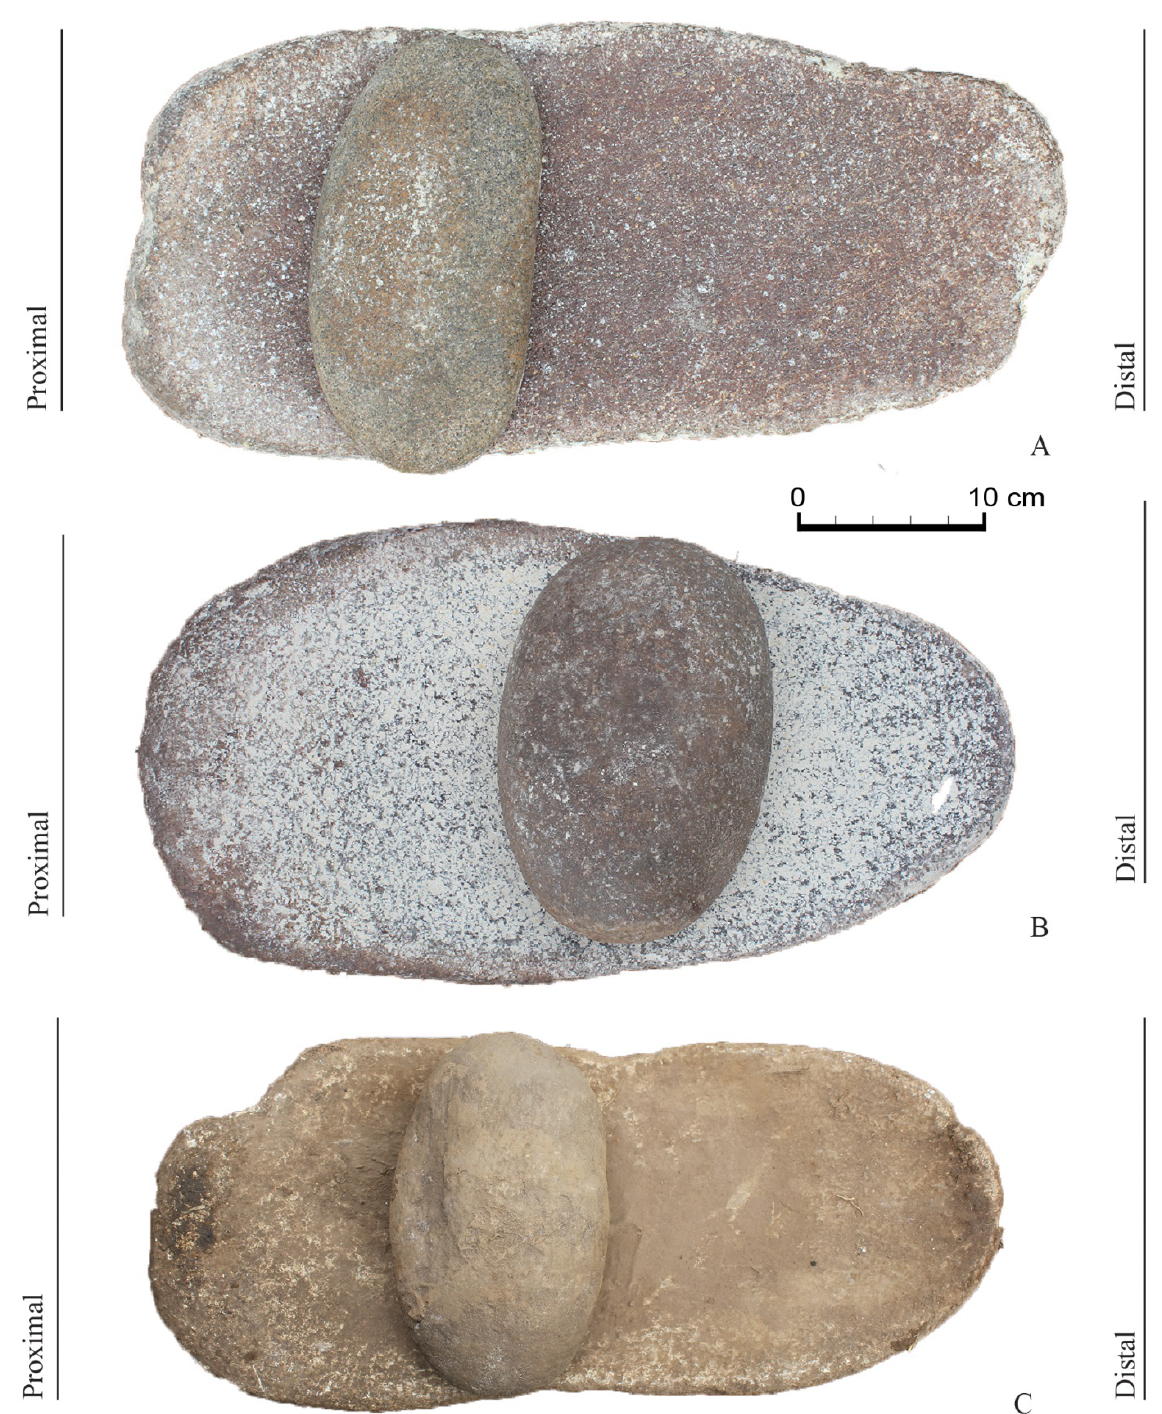
Figure 11. Querns and handstones used for different functions. A: Quern and handstone used for milling and crushing (wheat, sorghum, and corn). Quern: L. 54 cm; w. 23 cm; h. 8 cm. Handstone: L. 23.3 cm; w. 13.5 cm; h. 4 cm. B: Quern and handstone used for milling cereals (wheat and sorghum). Quern: L. 51 cm; w. 27.5 cm; h. 12.5 cm. Handstone: L. 25 cm; w. 14 cm; h. 7 cm. C: Quern and handstone re-used by a young girl to practice milling and crushing (earth and mud). Quern: L. 44 cm; w. 19 cm; h. 7 cm. Handstone: L. 18.5 cm; w. 11.5 cm; h. 7.5